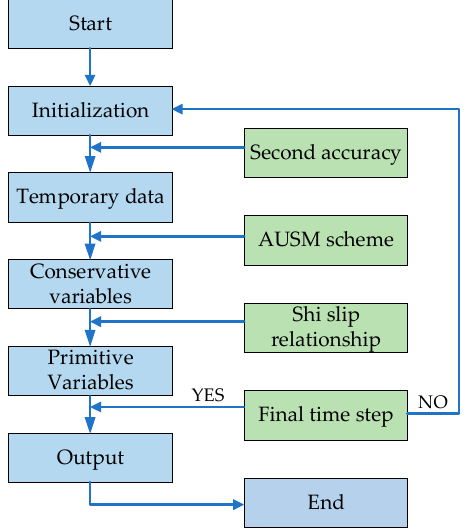
Figure 3. The main calculation workflow. AUSM: advection upwind splitting method.